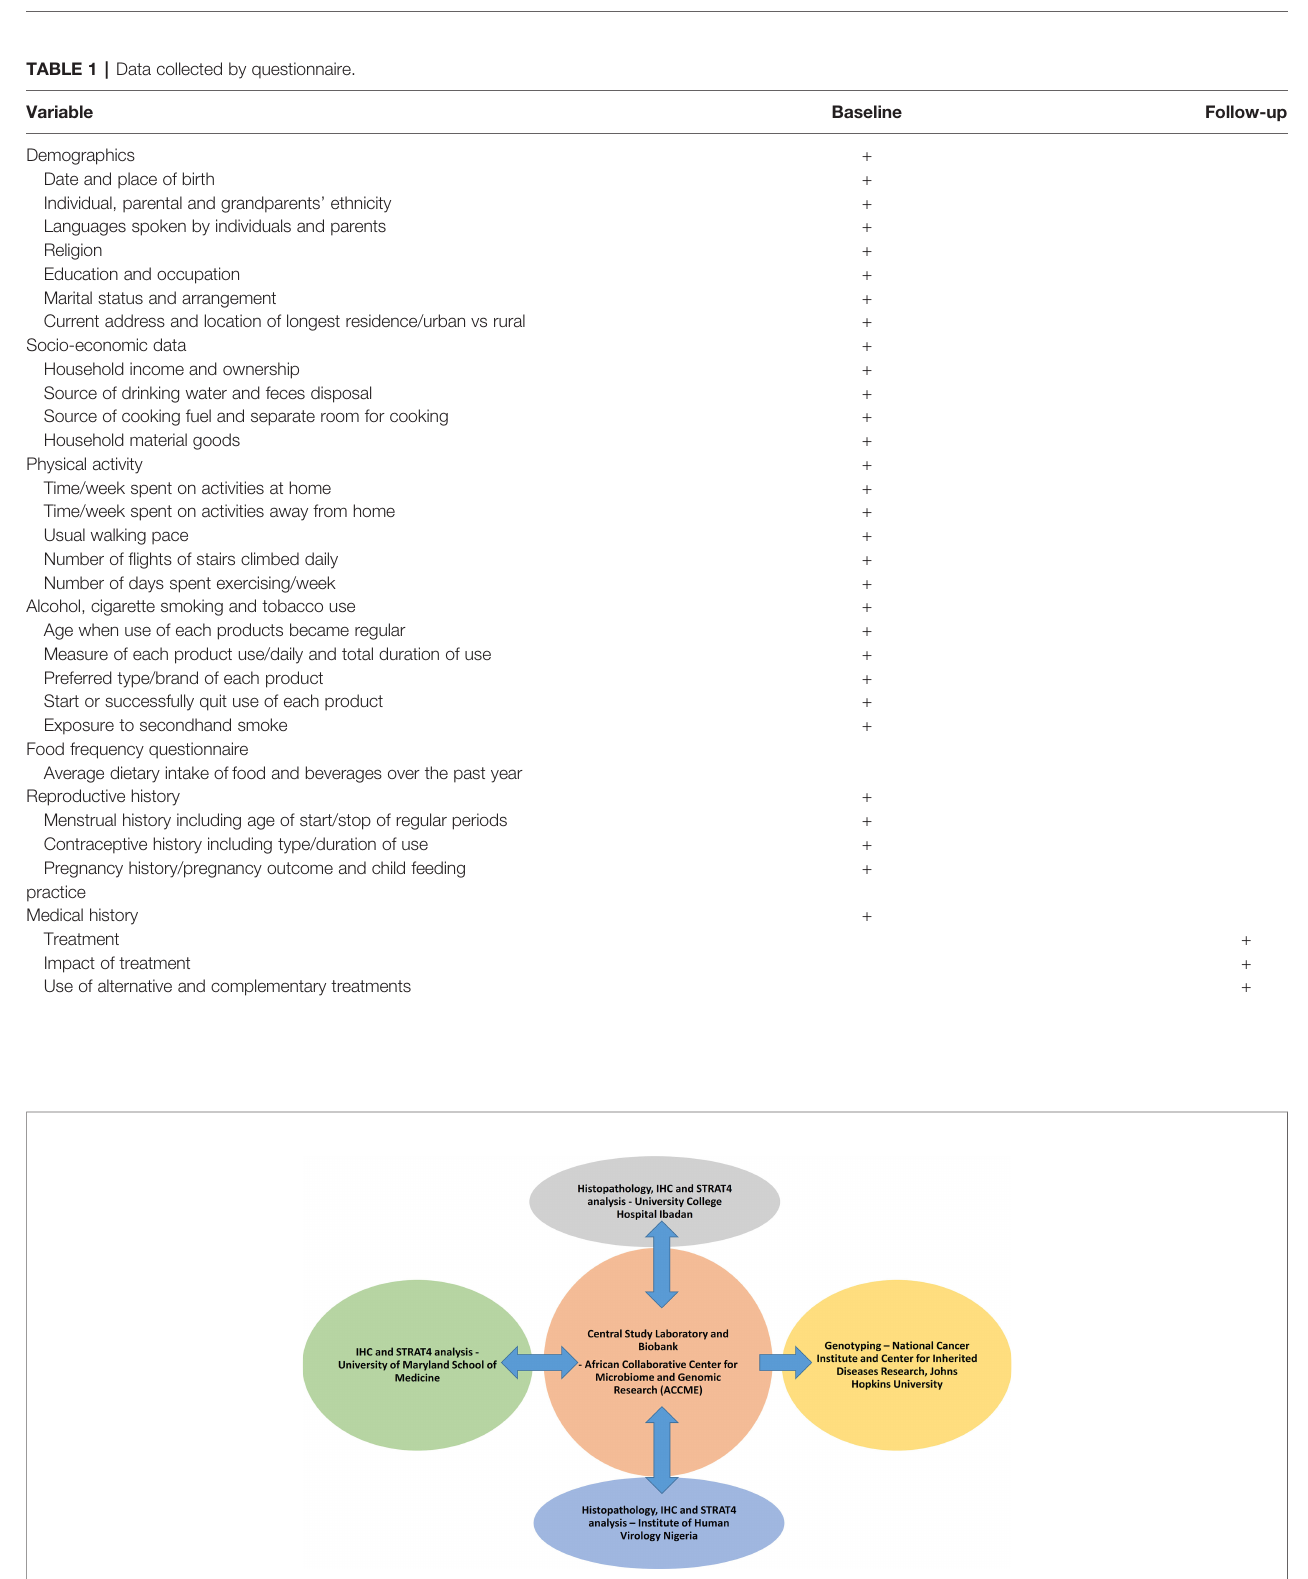
FIGURE 2 | Components of the AFBRECANE study conducted at different sites within and outside Nigeria.